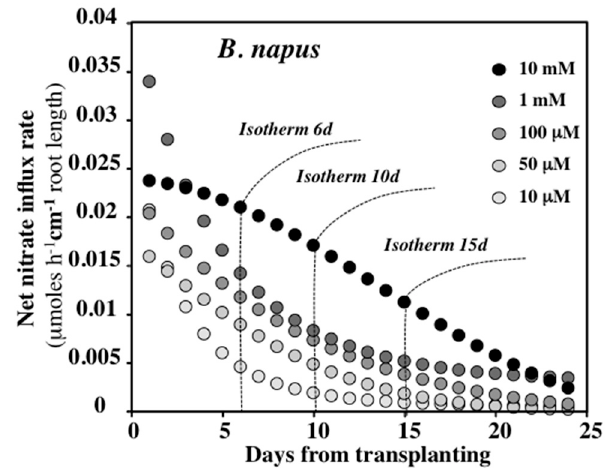
Figure 8 . Deterioration of net uptake rate with root age in Brassica napus plants. The plants were grown in a continuous flow culture system with constant 10 μ M, 50 μ M, 100 μ M, 1 mM, or 10 mM of external nitrate concentrations. The net absorption isotherm is defined as the measurement at a given temperature of the accumulation rate of an ion in the plant as a function of the external ion concentration (adapted from [100] and [19]).